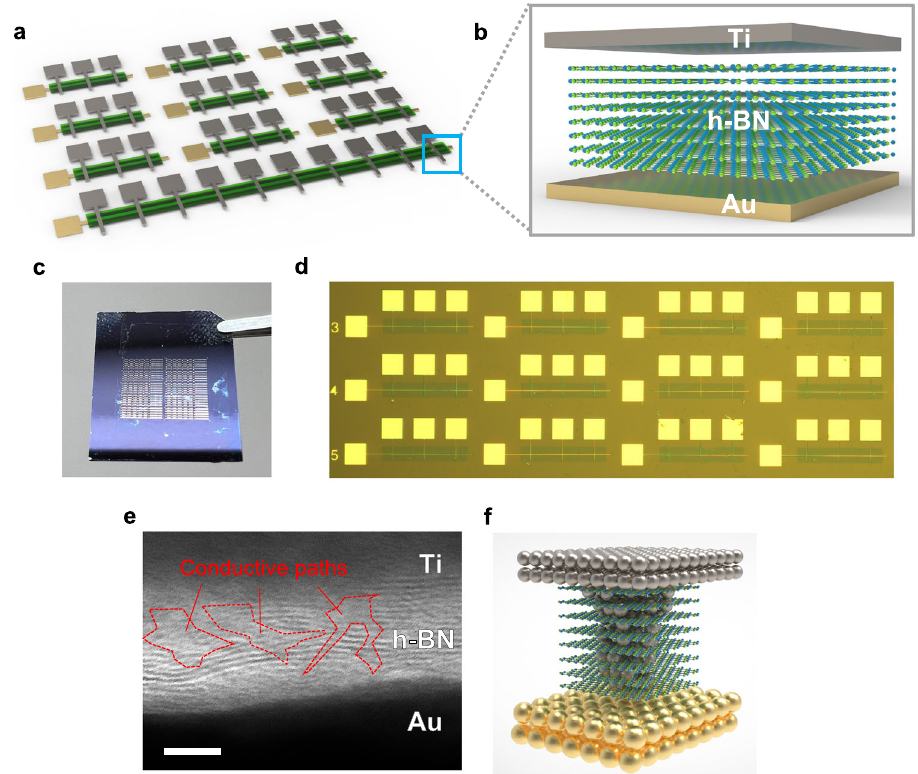
Fig. 1 hexagonal Boron Nitride (h-BN) memristor arrays. a Schematic of the Au/h-BN/Ti memristor arrays and b cross-sectional schematic of single memristor c Photograph of Au/h-BN/Ti memristor arrays on 90 nm SiO 2 /Si wafer under ambient light, and d micrograph of arrays with 3 µm × 3 µm active areas. e Cross-sectional TEM image of the Au/h-BN/Ti memristor indicating local defects responsible for the formation of conductive paths. Scale bar, 5 nm. f A representation of conductive nano fi laments on the Au/h-BN/Ti and − 1 V). The cumulative distribution plot of the resistive states extracted at a read voltage of 0.1 V from all 100 cycles is shown in Fig. 2b. Two distinct states labeled as HRS (high resistance states) and LRS (low resistance state) are easily observed as their distributions are separated by approximately two orders of magnitude. Another illustration of the HRS and LRS distributions is provided in Fig. 2c where the resistances are plotted as a function of the cycle number. A histogram of the set and reset voltages corresponding to transitions between HRS and LRS is shown in Fig. 2d. All results indicate a stable and reliable RS bipolar operation. We also explore the dependence of the I – V characteristics and of the HRS and LRS statistics on h-BN memristor active area. In Fig. 2e we compare the I – V characteristics from devices with 3 µm × 3 µm, 20 µm × 20 µm, and 50 µm × 50 µm active areas. All devices were measured for 100 cycles and the results show good